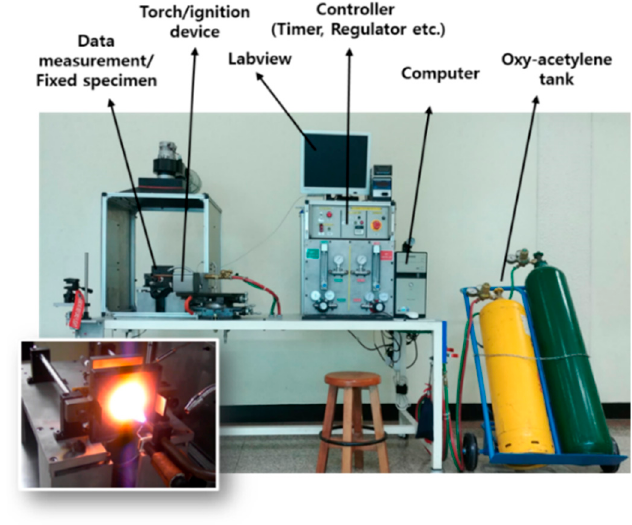
Figure 3. Oxy-acetylene torch test equipment.